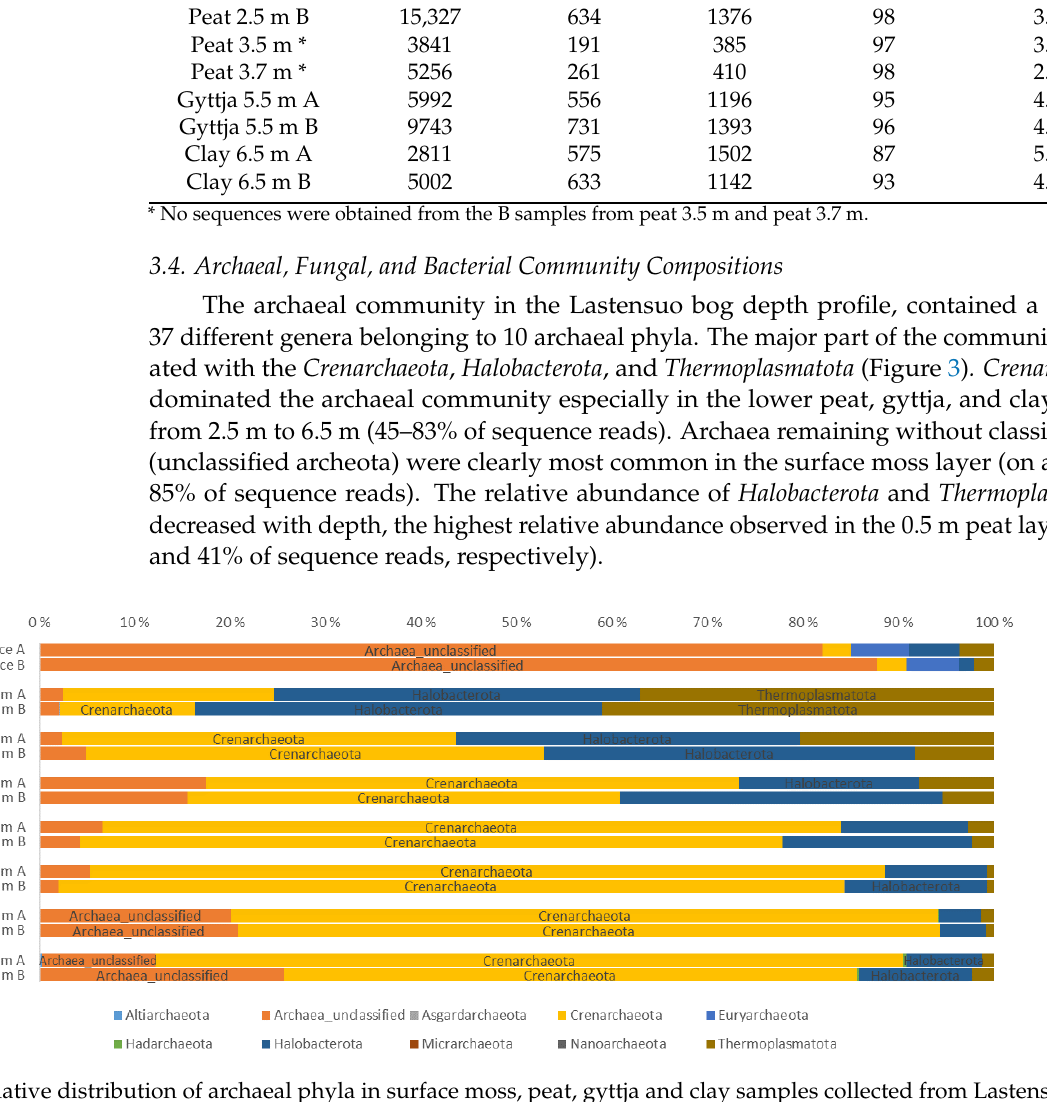
Figure 3. Relative distribution of archaeal phyla in surface moss, peat, gyttja and clay samples collected from Lastensuo bog. Each depth is represented by duplicate samples A and B.